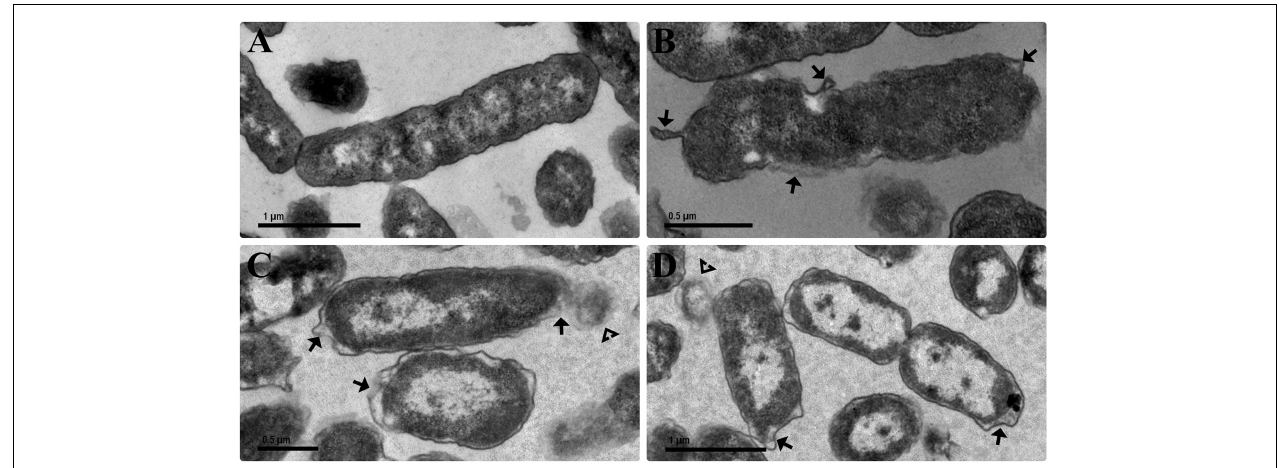
FIGURE 7 | Transmission electron micrographs of the antibacterial effect of the bioAgNP individually and in combination against E. coli ATCC 25922. Bacteria were exposed for 1 h to the bioAgNP at subinhibitory concentration. (A) Untreated control showing no changes in cell morphology and regular electron density. (B) BioAgNP-treated cells with morphological changes. (C,D) BioAgNP-treated cells with disruption of external ultrastructures and reduced electron density. Arrow: damaged cellular wall and cytoplasmic membrane. Arrowheads: leakage of cytoplasmic contents.